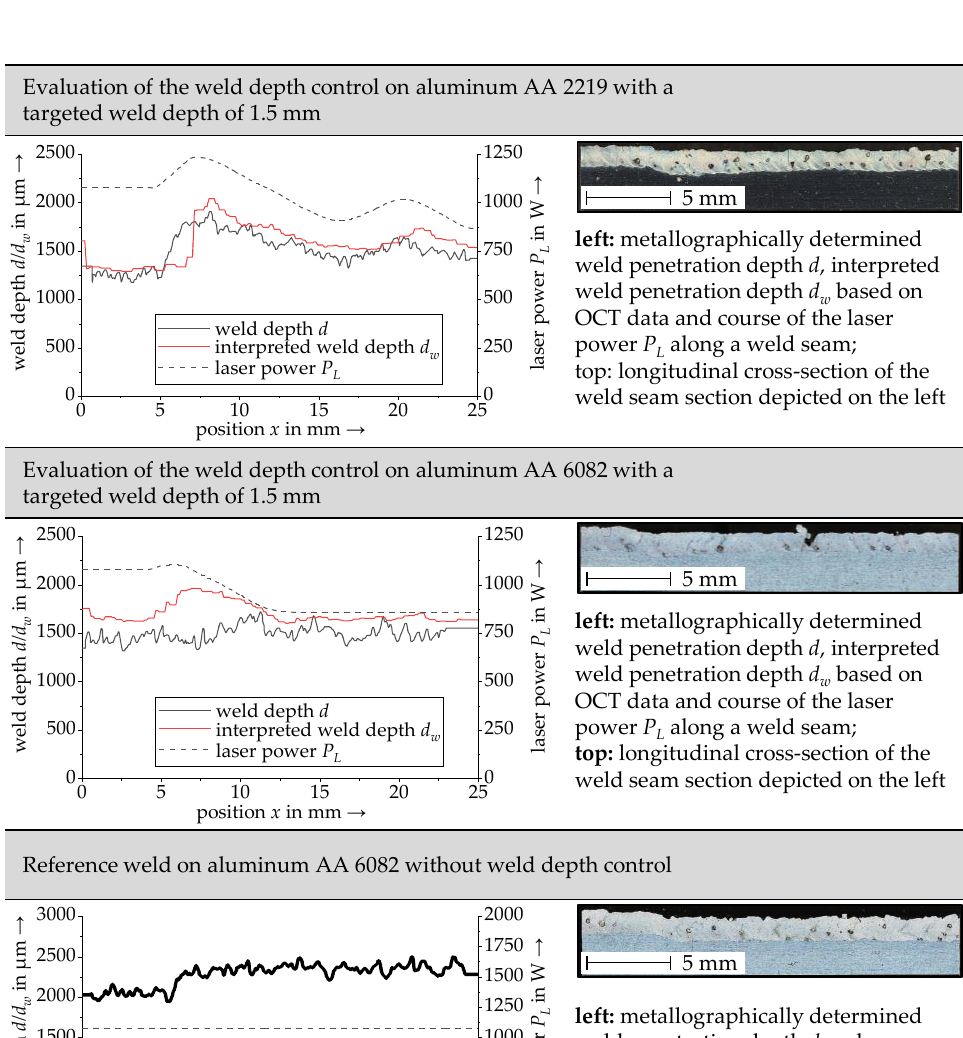
seam; top: longitudinal cross-section of the